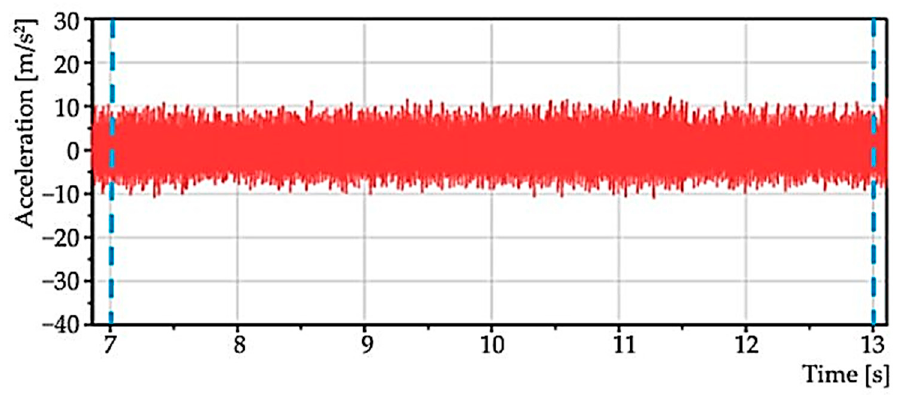
Figure 8. Zoom of the stationary area with the previous figure.